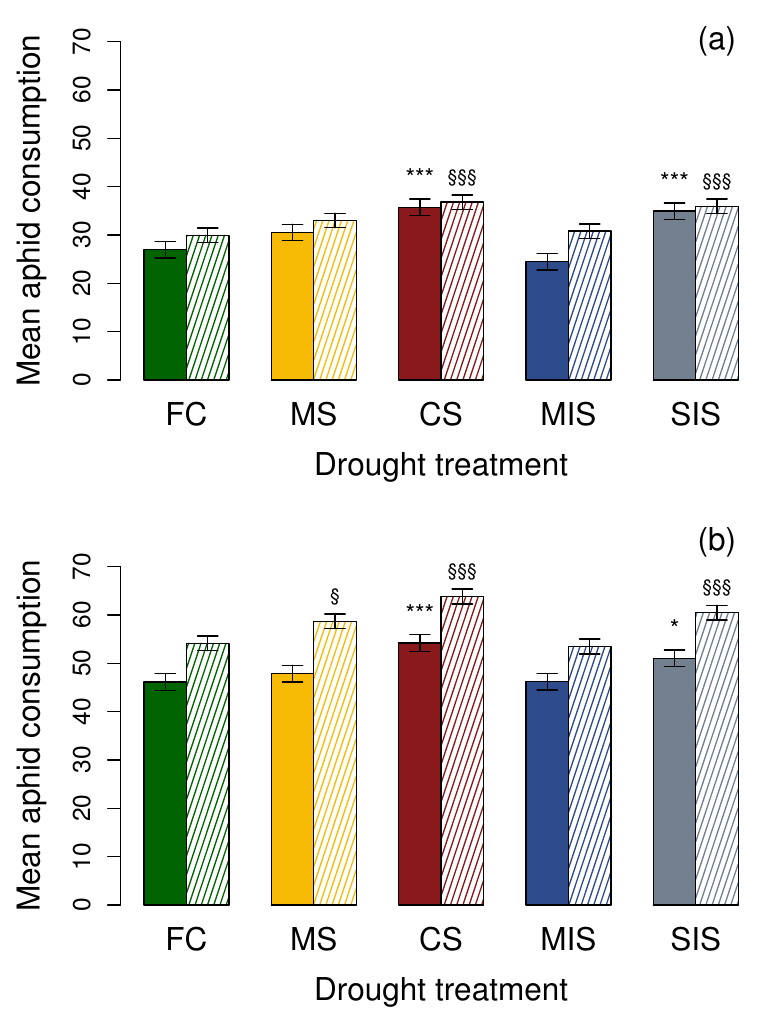
Figure 1. The effect of drought stress on mean number of 3rd instar E. abietinum consumption by ( a ) Aphidecta obliterata and ( b ) Adalia bipunctata adults, as number consumed over 24 h ± LSD. Solid colours = in presence of a Sitka spruce segment; Dashed = no Sitka spruce segment. Error bars and significance indicated against FC with respect to host plant presence or absence. FC = field capacity; MS = 60% field capacity; CS = 20% field capacity; MIS = allowed to fluctuate from 70% to 30% field capacity; SIS = allowed to fluctuate from field capacity to 20% field capacity. *** or §§§ = p < 0.001; ** or §§ = p < 0.01; * or § = p <